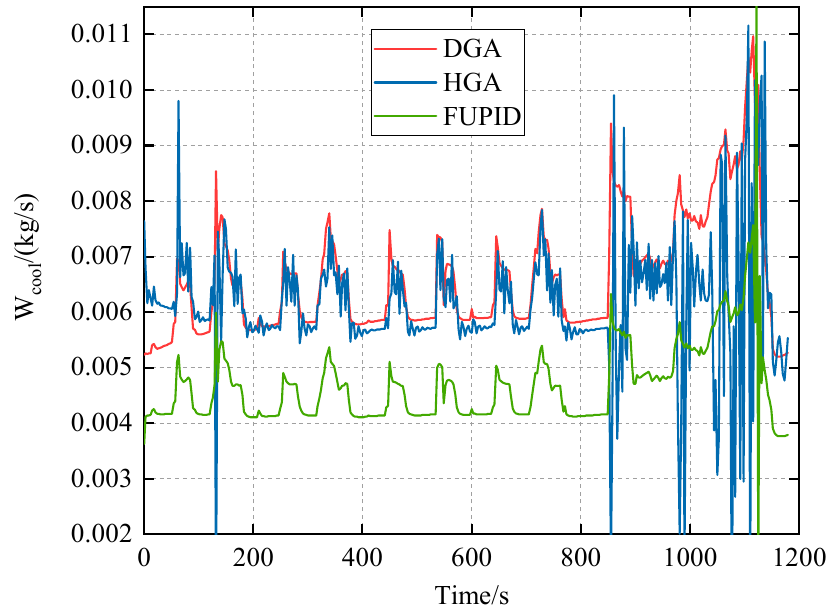
Figure 16. Three strategies Water flow variation map.